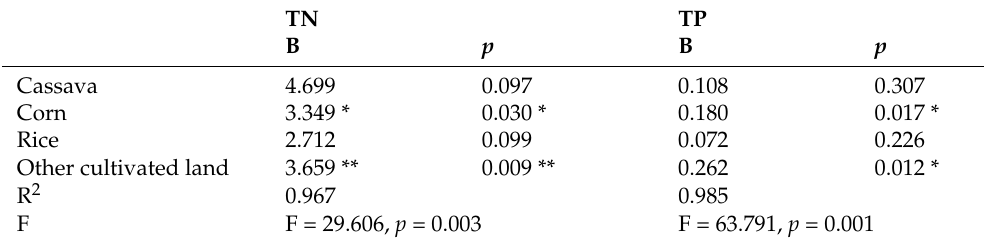
Table 6. Multiple linear regression analysis of TN and TP of different crops. TN